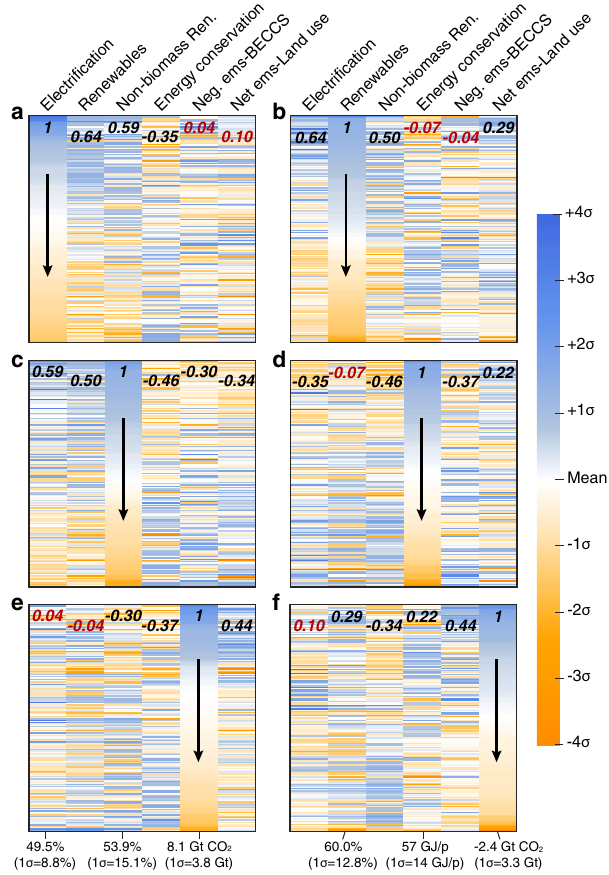
Fig. 4 Relative characteristics of scenarios in the global net-zero year. Panels show parameter standard deviations for scenarios (rows) sorted by ( a ) electri fi cation, ( b ) renewables share, ( c ) non-biomass renewables share, ( d ) energy conservation, ( e ) negative emissions from BECCS, and ( f ) net land-use emissions. “ Electri fi cation ” is the share of fi nal energy consumed as electricity. “ Renewables ” is the share of primary energy supplied by biomass, solar, wind, hydroelectricity, and geothermal. “ Non- biomass ren. ” is the share of renewable energy sources provided by sources other than biomass. “ Energy conservation ” here re fl ects the inverse of fi nal energy per capita, such that warmer colors indicate higher levels of energy consumption. “ Negative ems-BECCS ” is the total amount of negative emissions from bioenergy with carbon capture and storage. “ Net ems-land use ” is the net amount of global CO2 emissions related to land use. Mean and standard deviation for parameters are shown below each column, and pairwise correlation coef fi cients (r) are shown in bold at the top of each column. Black r-values are statistically signi fi cant ( p < 0.05), while red r-values are